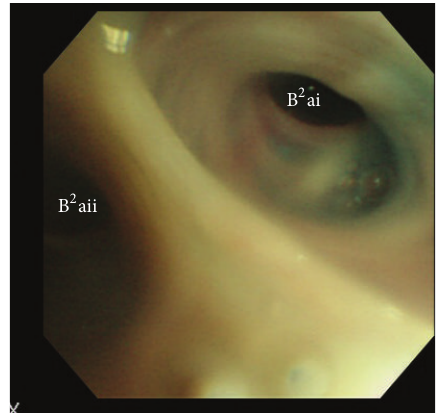
Figure 2: Indigo carmine is running out from the right B 2 ai bronchus. Figure 3: An EWS (small) is tightly inserted into the right B